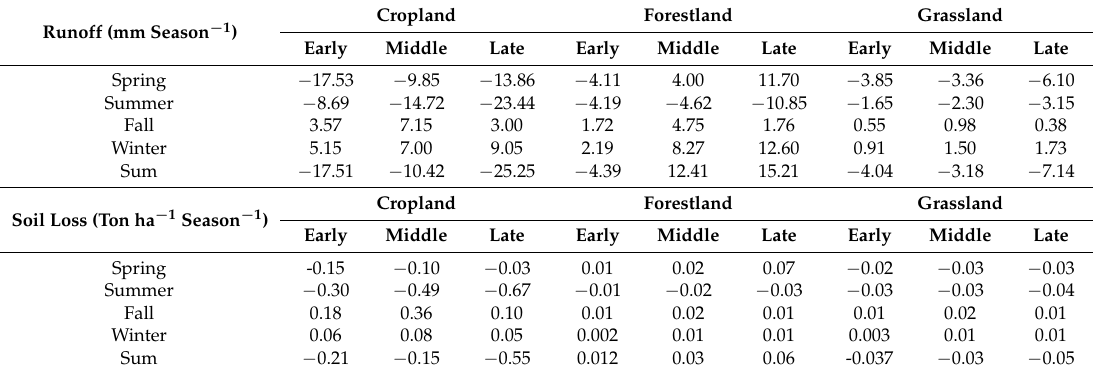
Table 7. Seasonal changes of runoff and soil loss over three future periods under A2